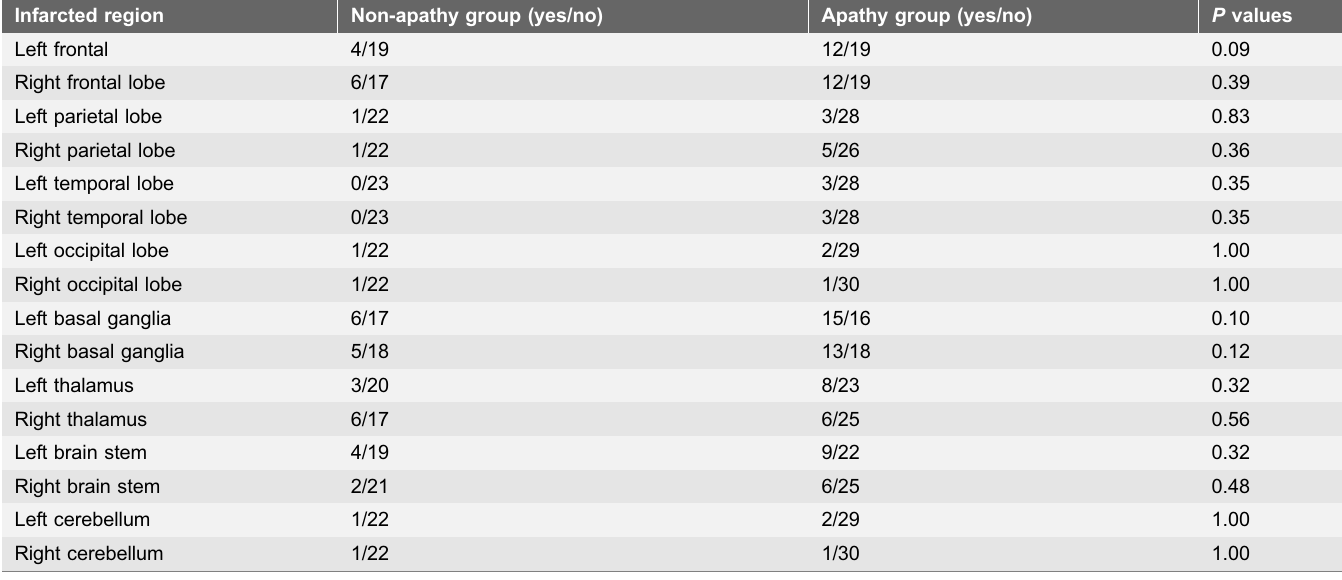
Table 2. Comparison of the number of cases with infarction between the two groups. Infarcted